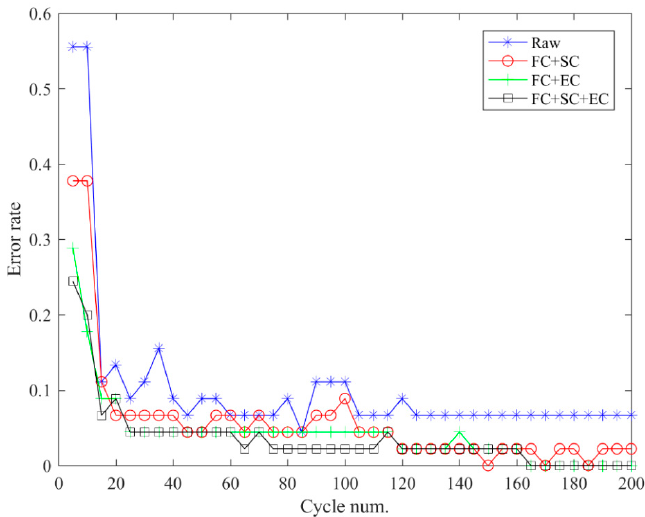
Figure 10. Error rate versus cycle number.